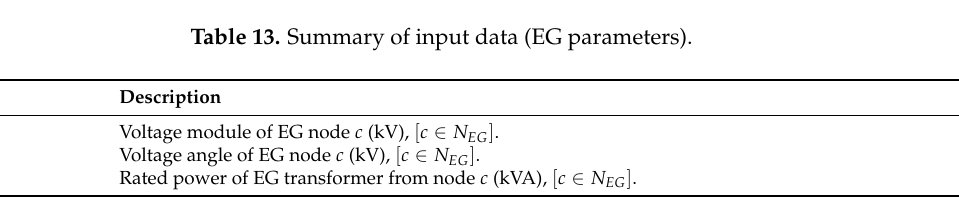
Table 14. Summary of input data (SS parameters).